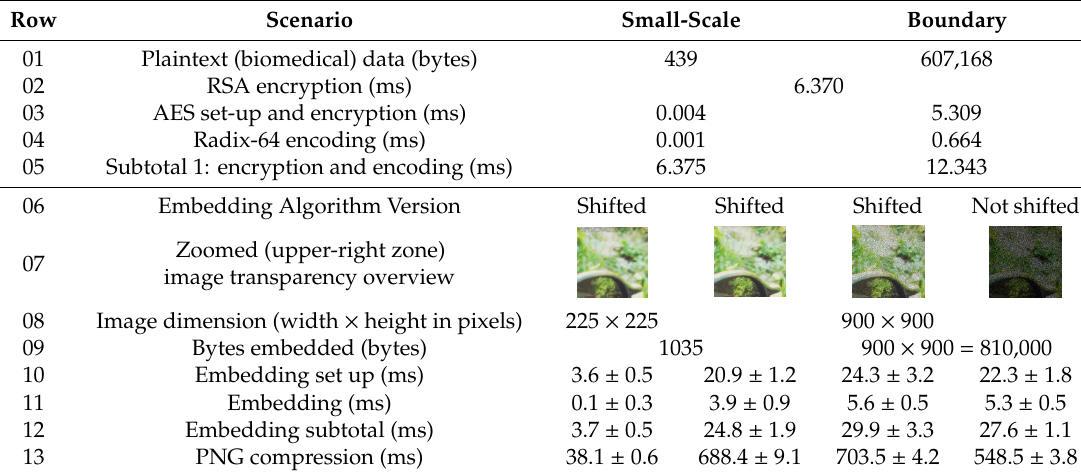
Table 2. Speed and size analysis.